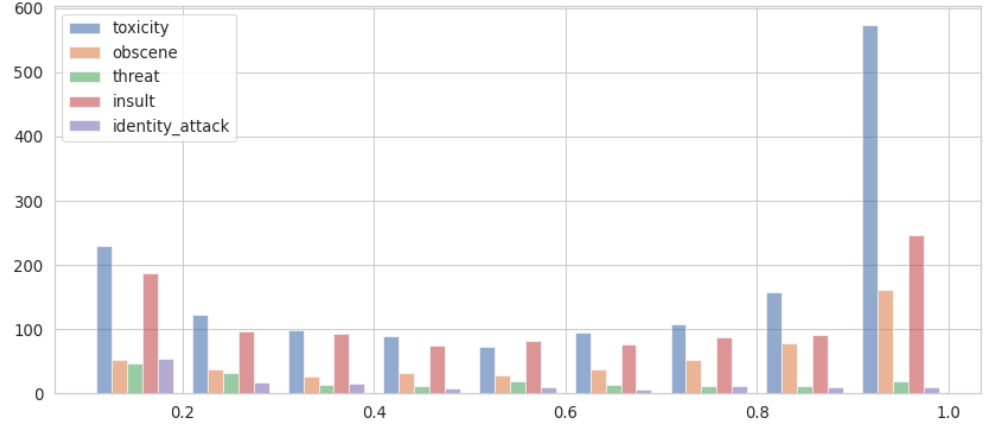
Figure 8. Histogram of BitChute toxicity detection on